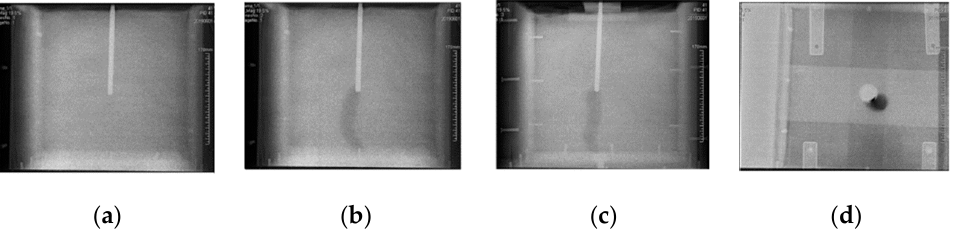
Figure 8. Image of the soil discharge channel before modification: ( a ) Before breakdown; ( b ) front view; ( c ) side view; ( d ) top view.